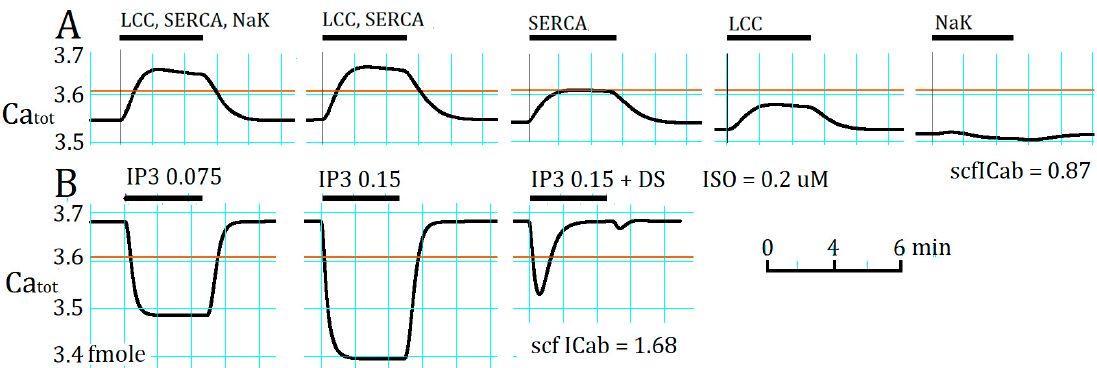
Figure 4. The influence of activating the individual components of NA-target molecules; ( A ) L-type Ca 2+ channel (LCC), s arcoplasmic/endoplasmic reticulum calcium pump (SERCA), and Na + /K + Ca 2 + channel (LCC), sarcoplasmic / endoplasmic reticulum calcium pump (SERCA), and Na + / K +